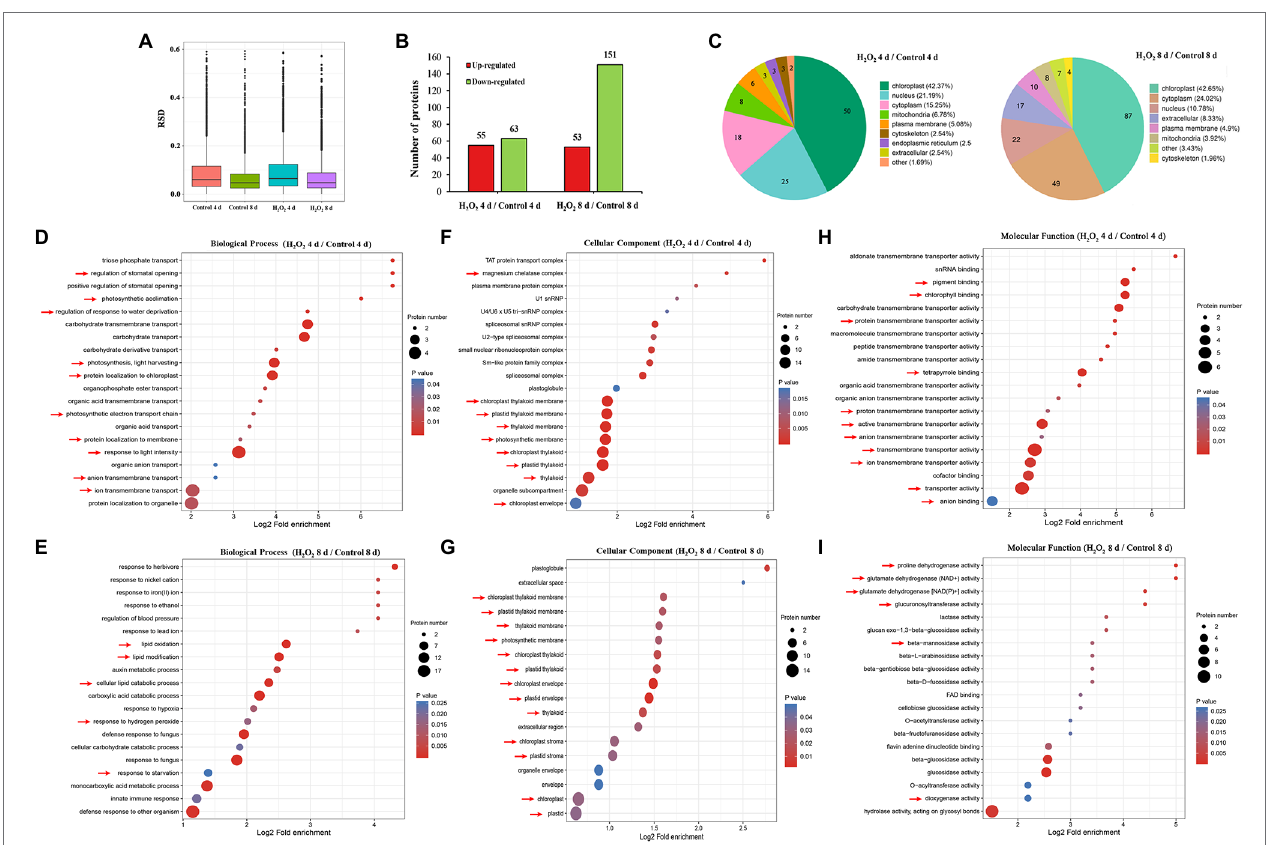
FIGURE 2 | Proteomic analysis (10 mM H 2 O 2 /Control) of Chinese flowering cabbage leaves during storage. The relative SD (RSD) between repeated samples (A) . The differentially regulated proteins of Chinese flowering cabbage leaf in the H 2 O 2 treatment group, a 1.5-fold change ( p < 0.05) compared to controls (B) . The sub- cellularly localization of H 2 O 2 -induced differentially regulated proteins (C) . The biological process (D,E) , cellular components (F,G) , and molecular function (H,I) functional annotations of total differentially expressed proteins of Chinese flowering cabbage leaf at day 4 and day 8 of